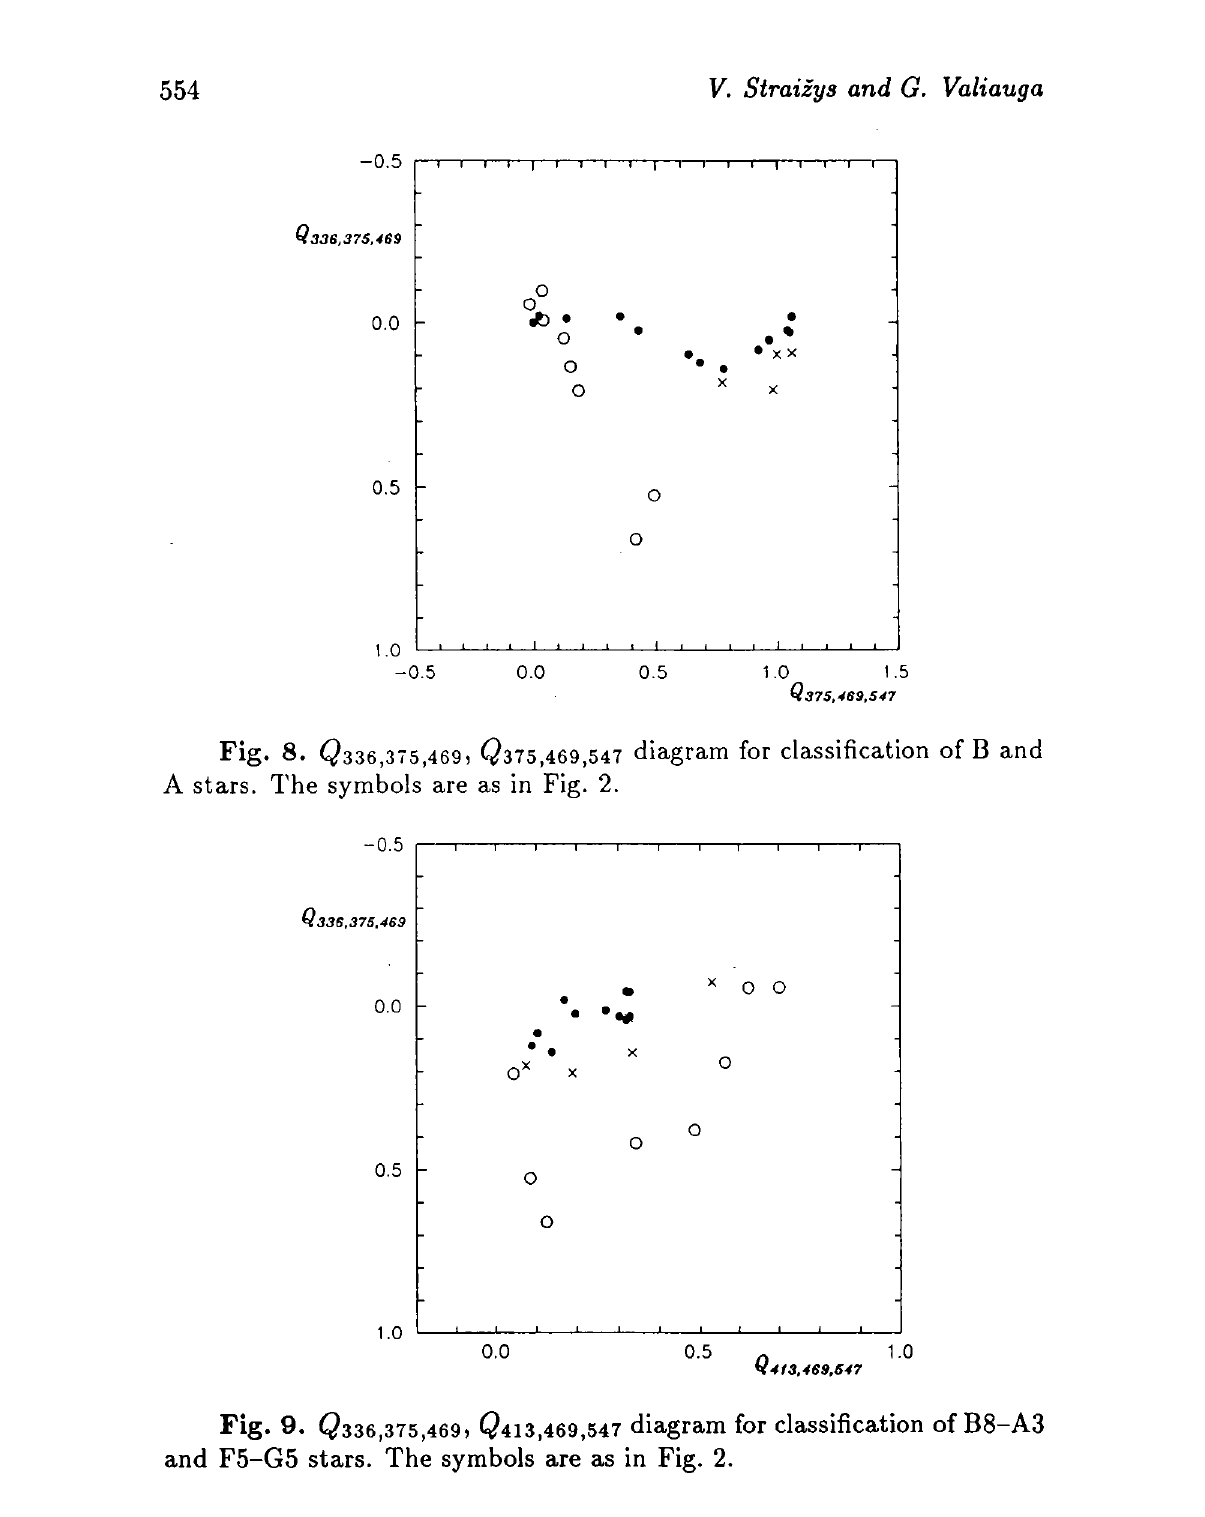
Fig. 9. <2336,375,469, $413,469,547 diagram for classification of B8-A3 and F5-G5 stars. The symbols are as in Fig.